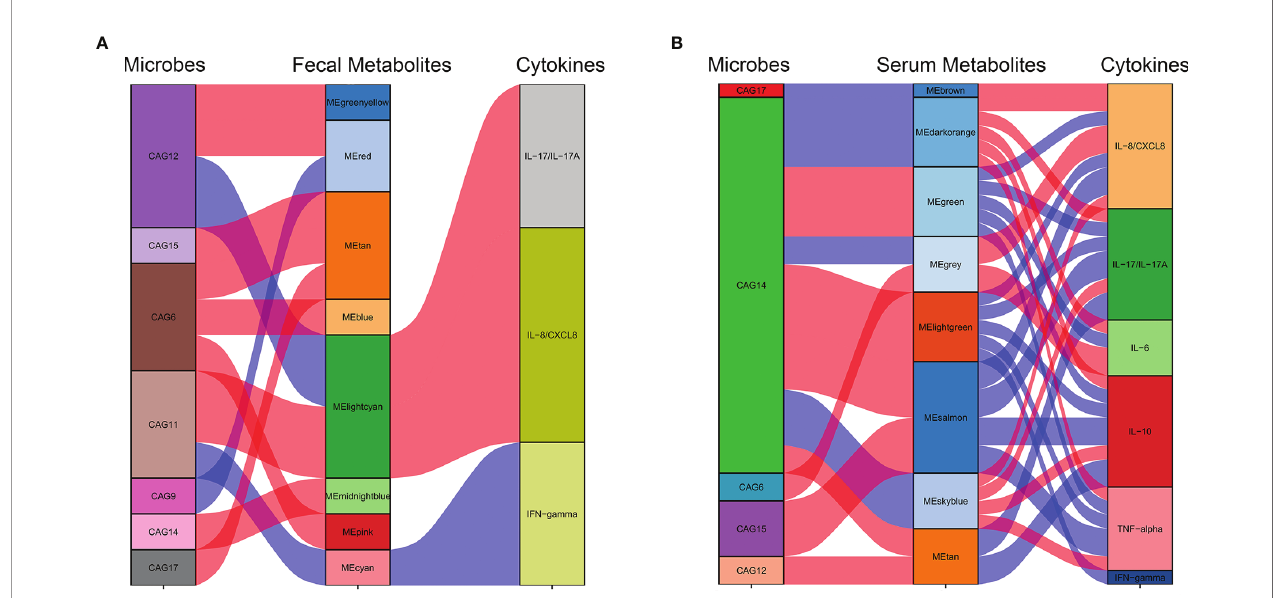
FIGURE 7 | Interrelationships between the gut microbiota composition, host metabolic pro fi les, and cytokine phenotypes. Correlation network between the gut microbiota of signi fi cant co-abundance groups (CAGs), fecal (A) and serum (B) metabolites, and cytokines. Red lines denote positive correlations (FDR < 0.05), while blue lines denote negative correlations (FDR < 0.05). In the gut microbiota column, green stratum denotes CAGs highly enriched in the control group. Stratum in brown denotes microbiota increased in the more severe group. In the metabolomics column, orange and red strata denote anti- N -methyl- D -aspartate receptor (NMDAR) encephalitis-negative metabotypes, while blue and green strata denote NMDAR encephalitis-positive